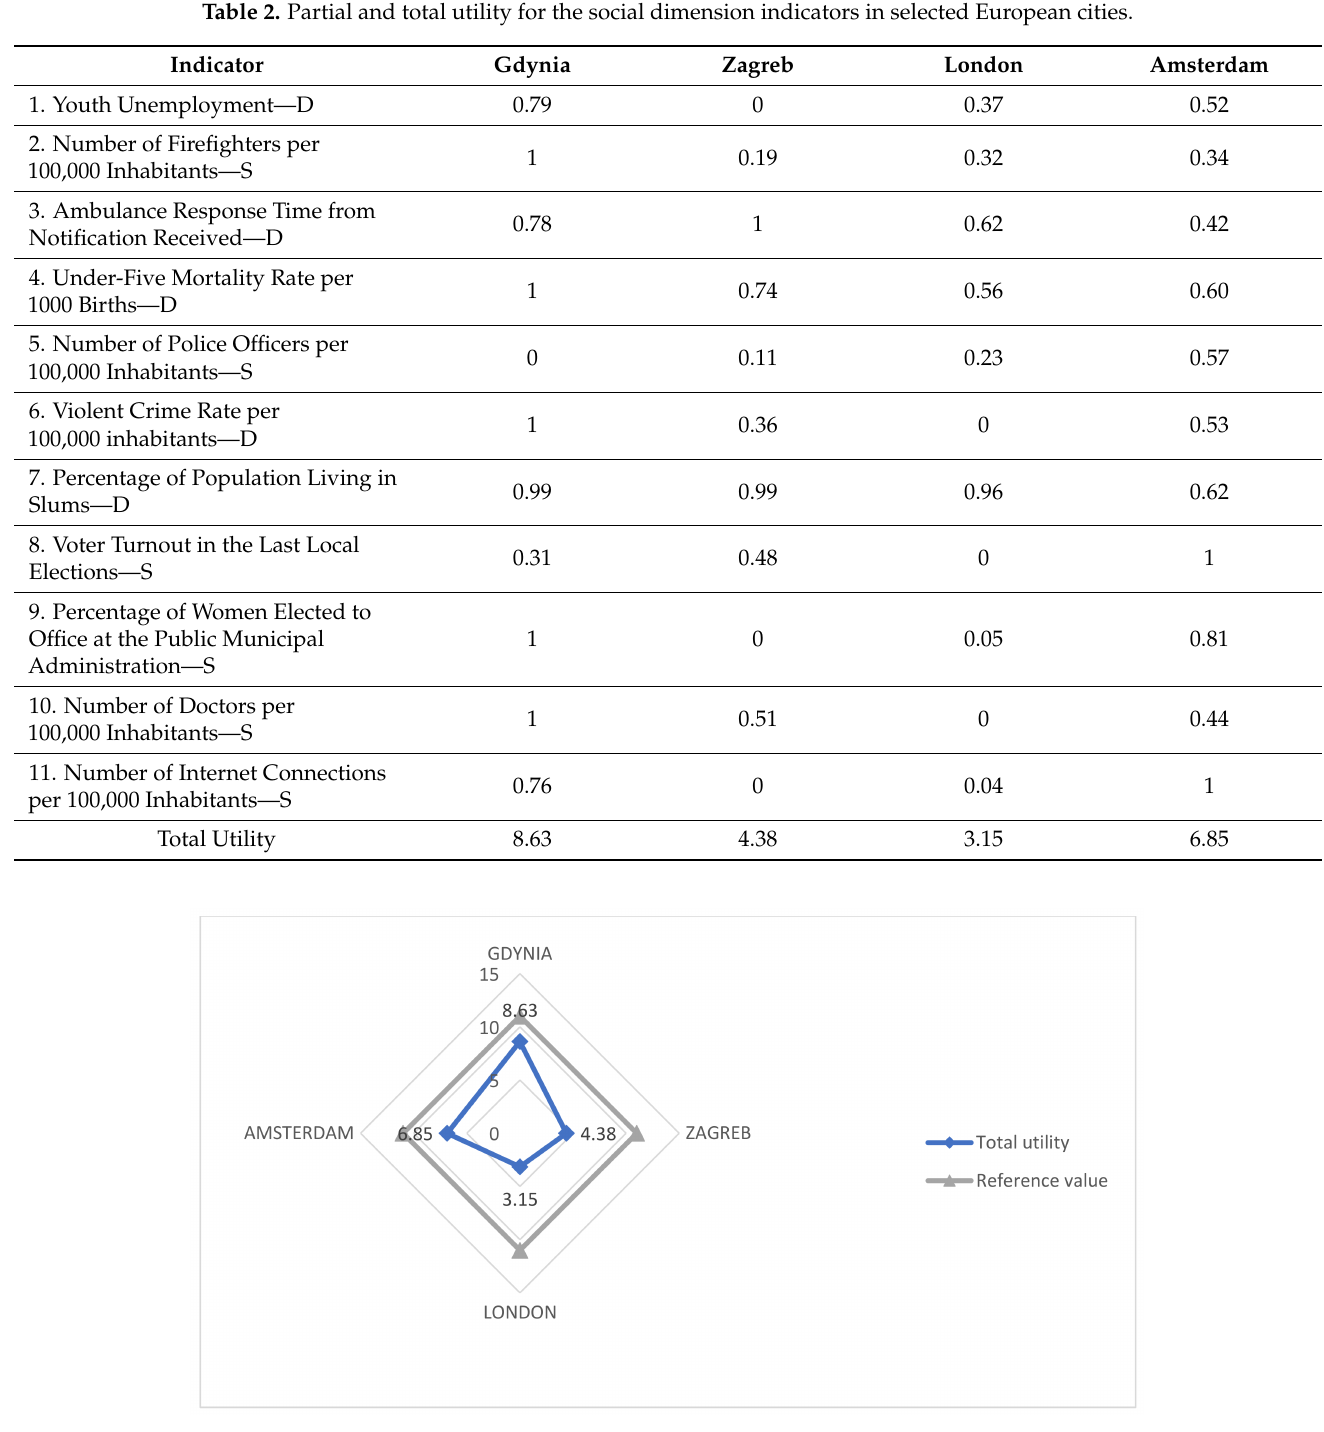
Figure 1. Total utility for the social dimension indicators in selected European